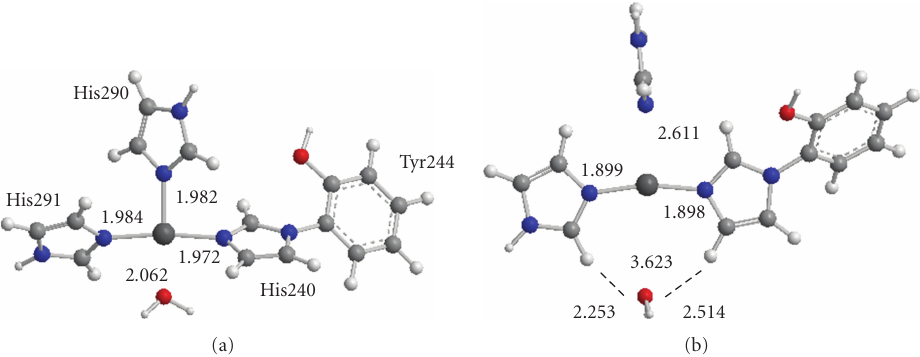
Figure 3: Optimized geometries of the Cu B site in which the Cu atom is coordinated by a H 2 O molecule as fourth ligand. The Cu atoms are an oxidized Cu(II) (A) and a reduced Cu(I)